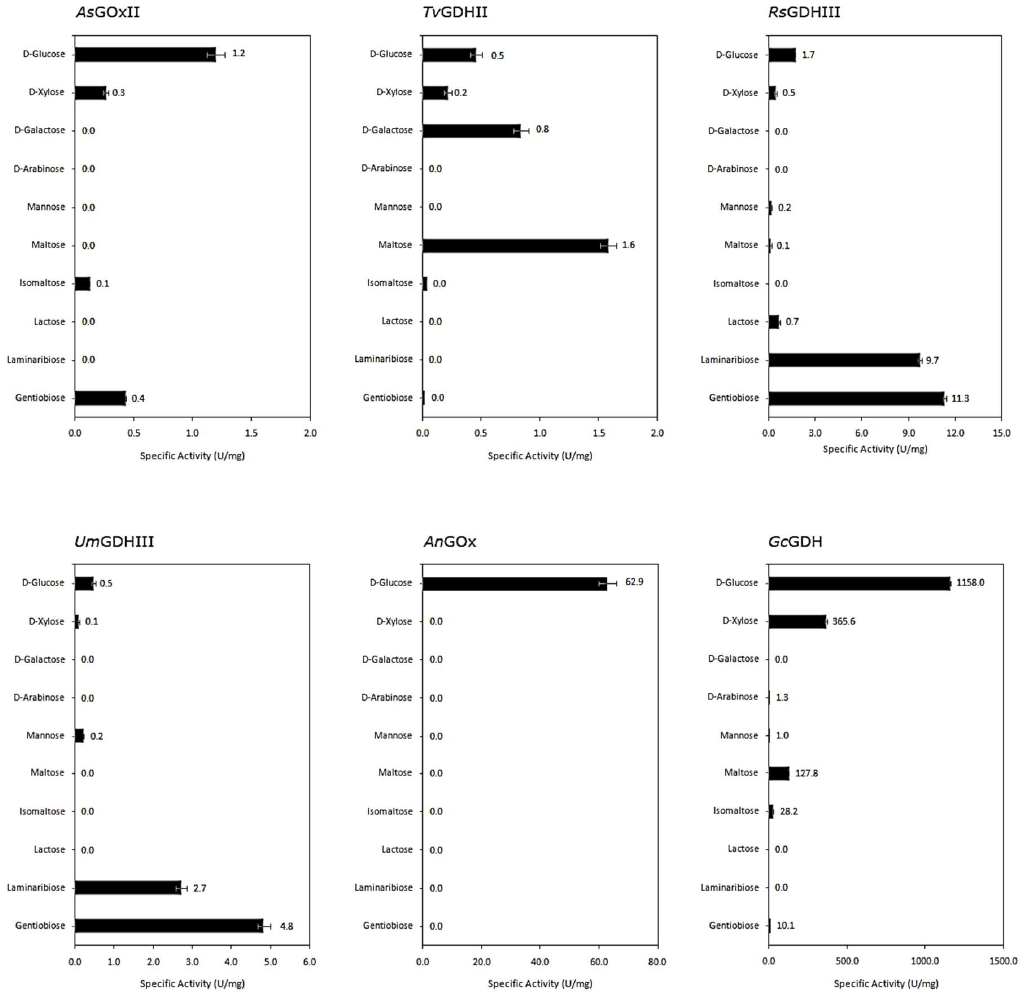
Figure 3. Sugar substrate spectrum of AA3-2 glucose oxidoreductases. Activities were measured using 0.5 mM 1,4-benzoquinone as electron acceptors and 100 mM of sugar substrates. Values represent the mean ± SD of triplicate independent measurements.